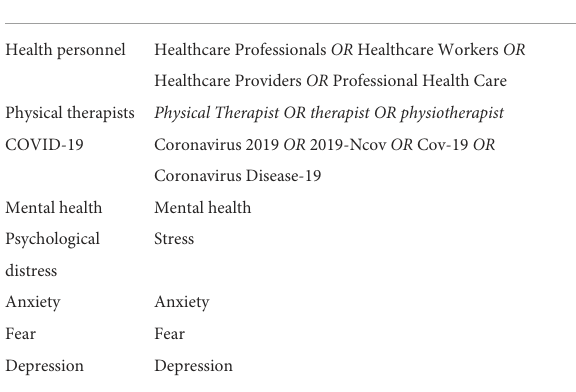
TABLE 2 Terms used in the search (Rehabilitation and COVID-19, Spain, 2022).